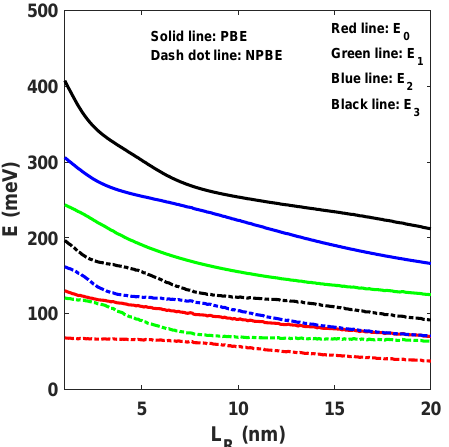
Figure 2. The ground state and the three excited states E 1 , E 2 and E 3 as a function of the width of right-hand well L R